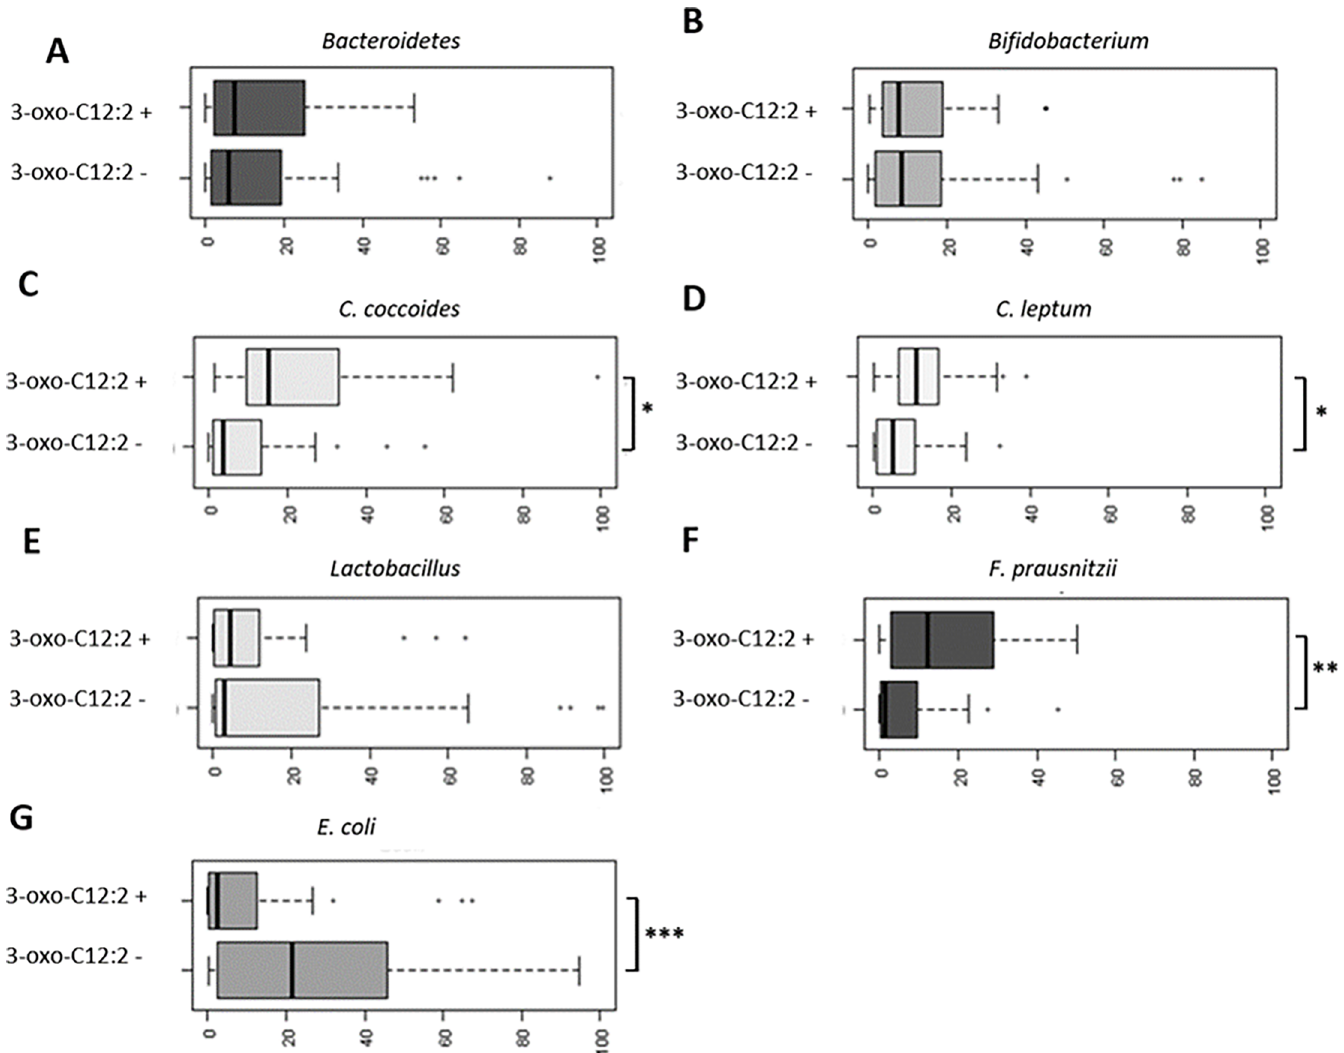
Fig 7. Relative quantification (2^-DDCT) of gut microbiota principal bacterial groups and species. (cid:3) p < 0.05 (cid:3)(cid:3) p < 0.005 (cid:3)(cid:3)(cid:3) p <